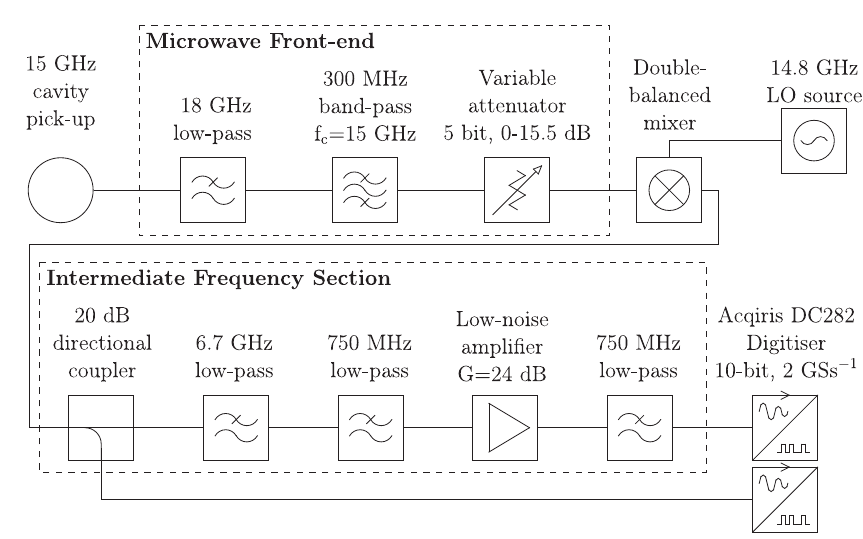
FIG. 5. Design of a single digital down-converter channel used for the beam